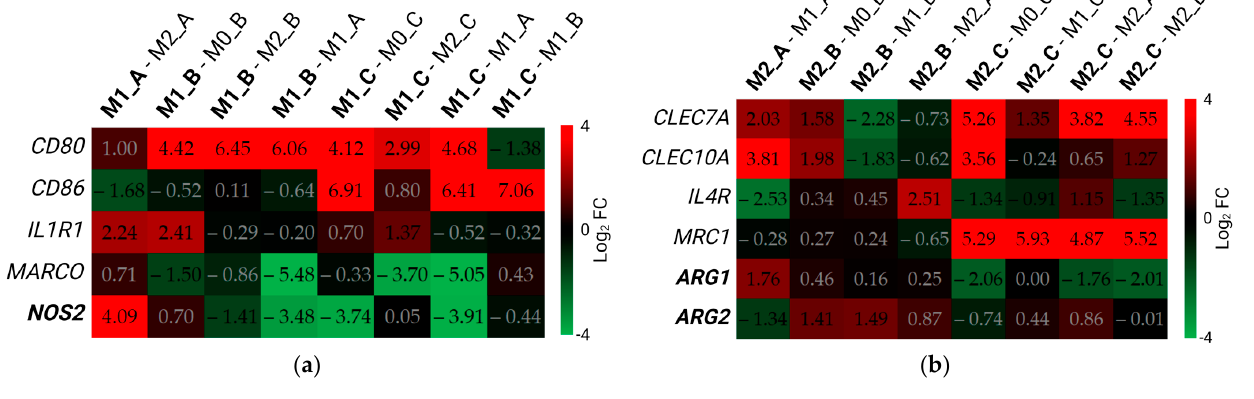
Figure 8. Differential expression of genes for receptors and enzymes. Data in the figure are presented as log 2 (FC). The threshold for differentially expressed genes was set as |log 2 (FC)| ≥ 1 with an adjusted p -value of padj ≤ 0.05. DEGs are represented with digits in black font. Comparisons between different samples are displayed in the upper part of the figure along the x-axis. Genes for enzymes are displayed in bold letters. FC—fold change. DEGs—differentially expressed genes. ( a ) M1 gene set; ( b ) M2 gene set. Created with BioRender.com; accessed on 14 th November 2022. The M2 gene set (Figure 8b) consisted of four gene-coding receptors ( CLEC7A , CLEC10A , IL4R , and MRC1 ) and two genes for arginase ( ARG1 and ARG2 ). Out of this gene set, MRC1 and CLEC7A were over-expressed in M2_C compared with all other pro- tocols and polarization states. CLEC10A was also over-expressed in M2_C when com- pared with M0_C and M2_B but not compared with M1_C and M2_A. While M2_A cells over-expressed ARG1 , M2_B macrophages over-expressed ARG2 compared with other cells from their respective protocols. 3.4. GO Enrichment Analysis We next performed the GO (gene ontology) enrichment analysis to identify func- tional enrichment in genes that were differentially expressed in our samples. Firstly, we determined GO enrichment in genes significantly expressed in M1 macrophages from Protocols B and C versus their respective M0 differentiation statuses (Tables 3 and 4). We also included the comparisons between different protocols. Since M1_ B seemed to differ- entially express the highest number of pro-inflammatory genes, in this analysis, we fo- cused mainly on the macrophages from the Protocol B. Therefore, we do not include com- parisons we considered less relevant (e.g., M1_A versus M1_C, etc.) Table 3. Top 10 biological processes significantly (padj ≤ 0.01) enriched in genes differentially ex- pressed in M1_B versus M0_B macrophages. GO ID